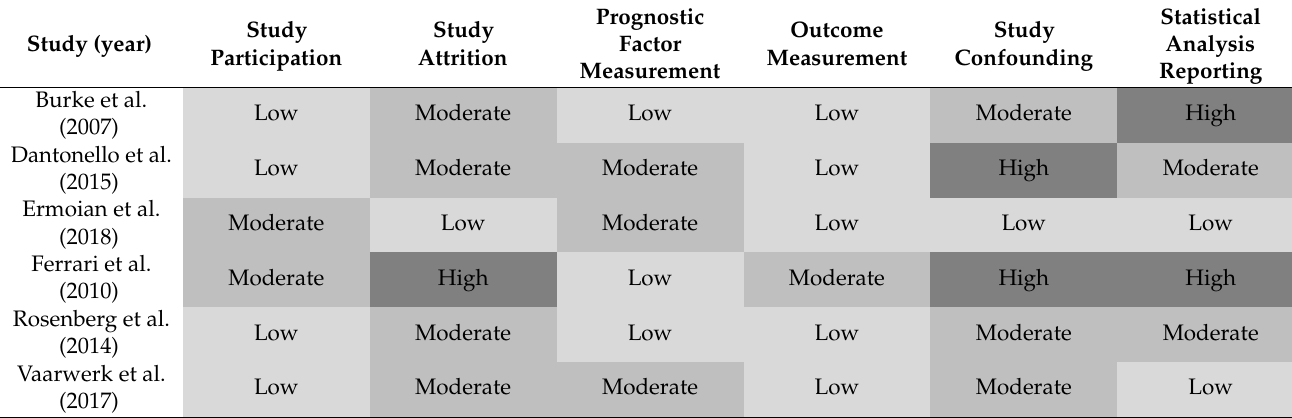
Table 3. Quality assessment, based on Quality in Prognosis Studies (QUIPS) [16] instrument, assessing the prognostic value of early tumor size response to chemotherapy in pediatric